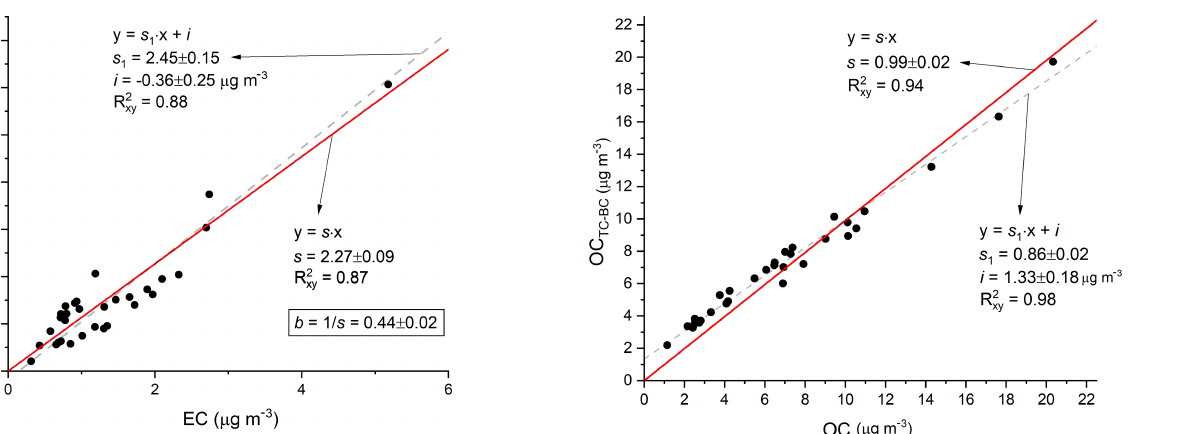
Figure 8. Comparison of offline measurements of OC (laboratory filter analysis) using the EUSAAR_2 thermal protocol to the 24h average of online measurement of OC = TC − b BC data taken by the AE33 Aethalometer and TCA08 Total Carbon Analyzer. Lin- ear orthogonal regression results ( n = 31) are shown with s as the slope (red line) for the model without an intercept and with s 1 as the slope and i as the intercept (dashed gray line) for the model with an intercept. R 2 xy is the square of the Pearson correlation